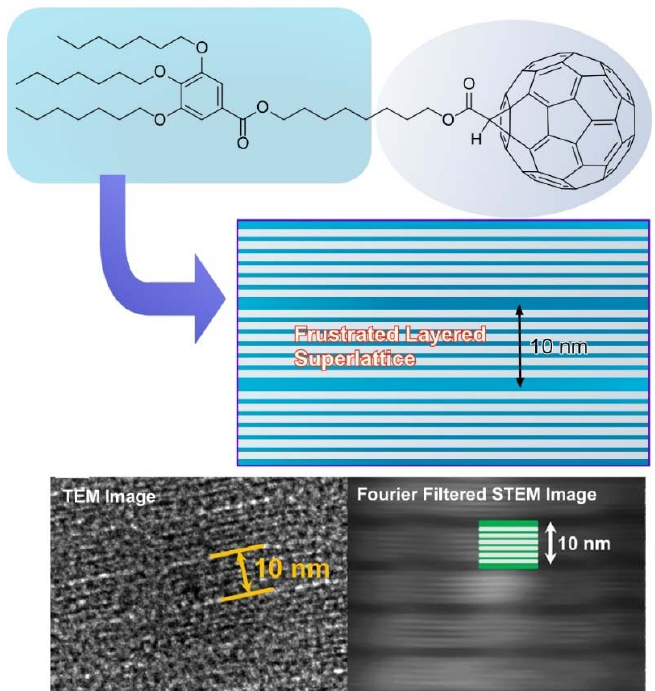
Figure 11. Frustrated layered superlattice as flat nanosheets with sublayer (~2 nm) and superlayer (~10 nm) lamellar thickness. Reprinted with permission from [122]. Copyright 2020 American Chemical Society.